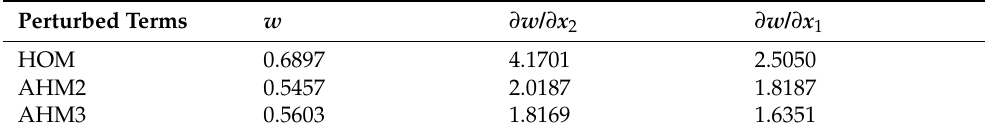
Table 6. DRSS for the SFSF four-layer periodic